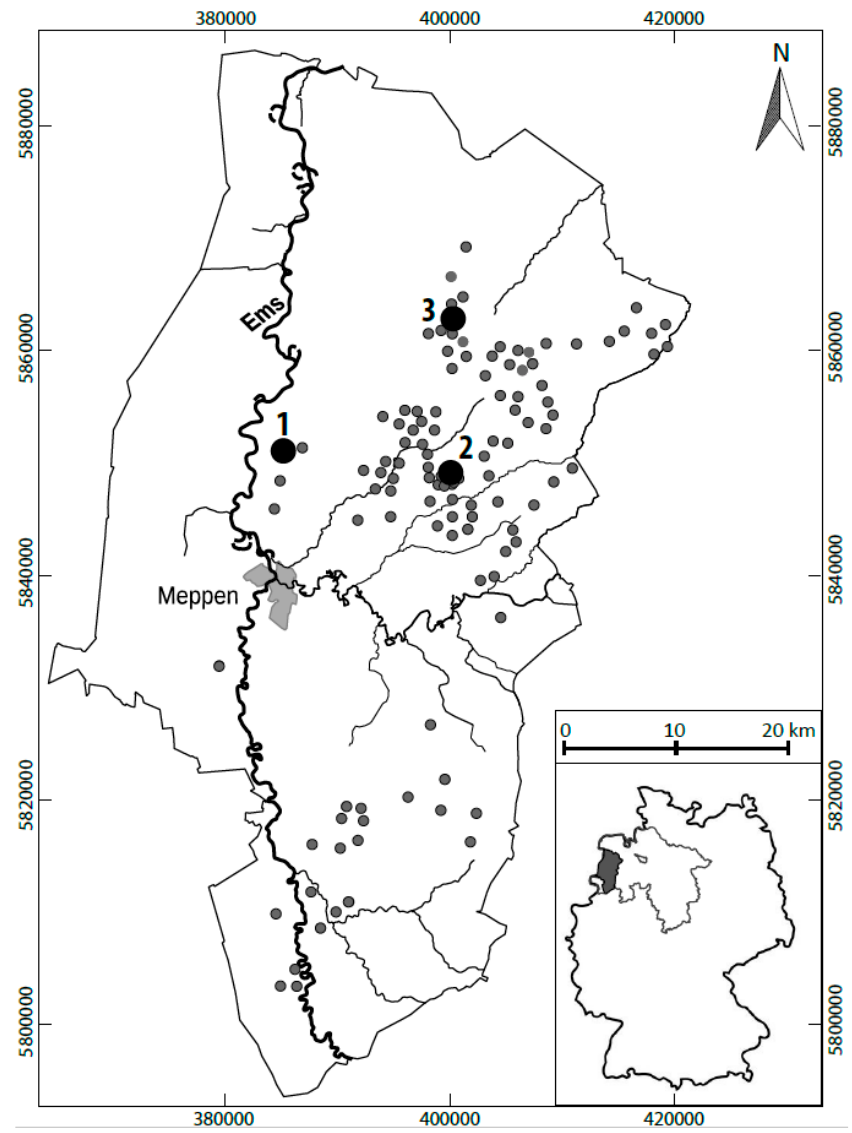
Figure 1. Distribution of megalithic graves in the study area, district Emsland, Lower Saxony, Germany. Grey dots = megalithic grave, black dots = examined sites (1: Emmeln 2, E2; 2: Groß Berßen 7, GB7; 3: Werpeloh 43, WP43). See Table 1 for more details.